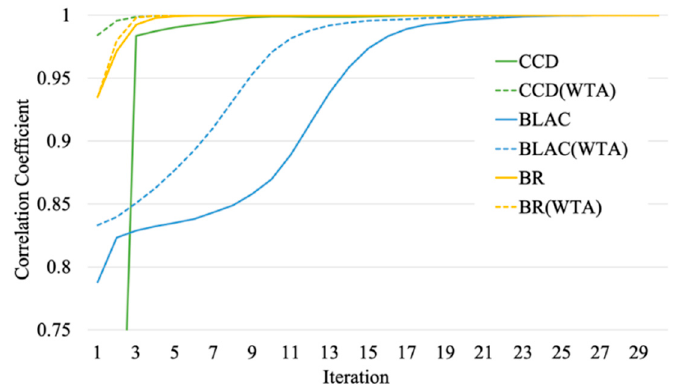
Figure 1. Correlation coefficients between intermediate and final merged models. The solid lines show the data with the “weighted” merging strategy, and the dashed lines show the data with the “winner-takes-all” (WTA) strategy.